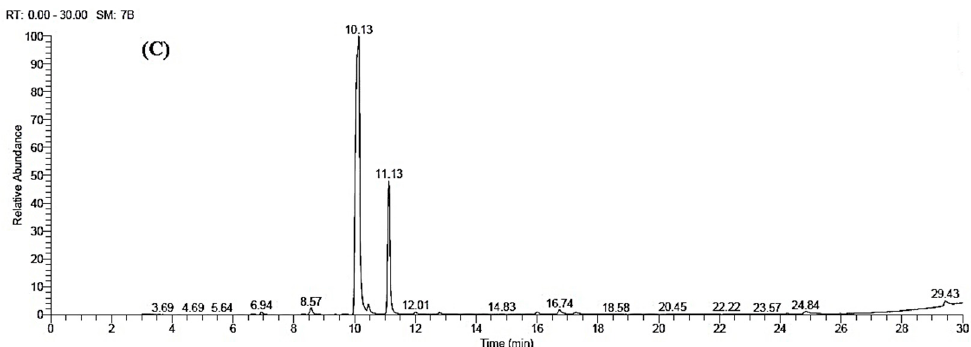
Figure 1. Chromatograms of GC / MS of the essential oils from ( A ) E. camaldulensis oil, ( B ) C. aurantium oil, and ( C ) C. sinensis.